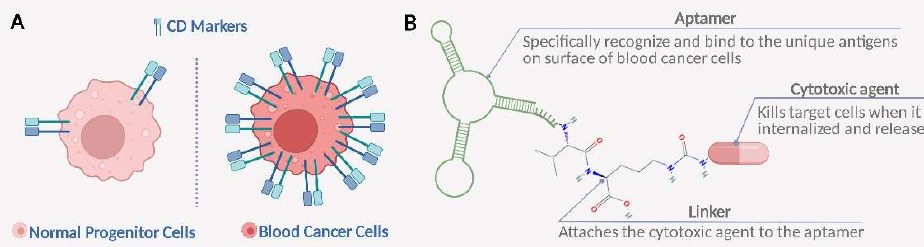
Figure 1. Scheme of targeted therapy for hematologic malignancies by ApDCs. ( A ) Certain CD markers are preferentially expressed in blood cancer cells, with low or no expression in normal hematologic progenitor cells. ( B ) Aptamer–drug conjugates consist of an aptamer targeting the unique membrane protein in blood cancer cells, a potent cytotoxic agent and a linker attaching the drugs to the aptamer. Created with BioRender.com.